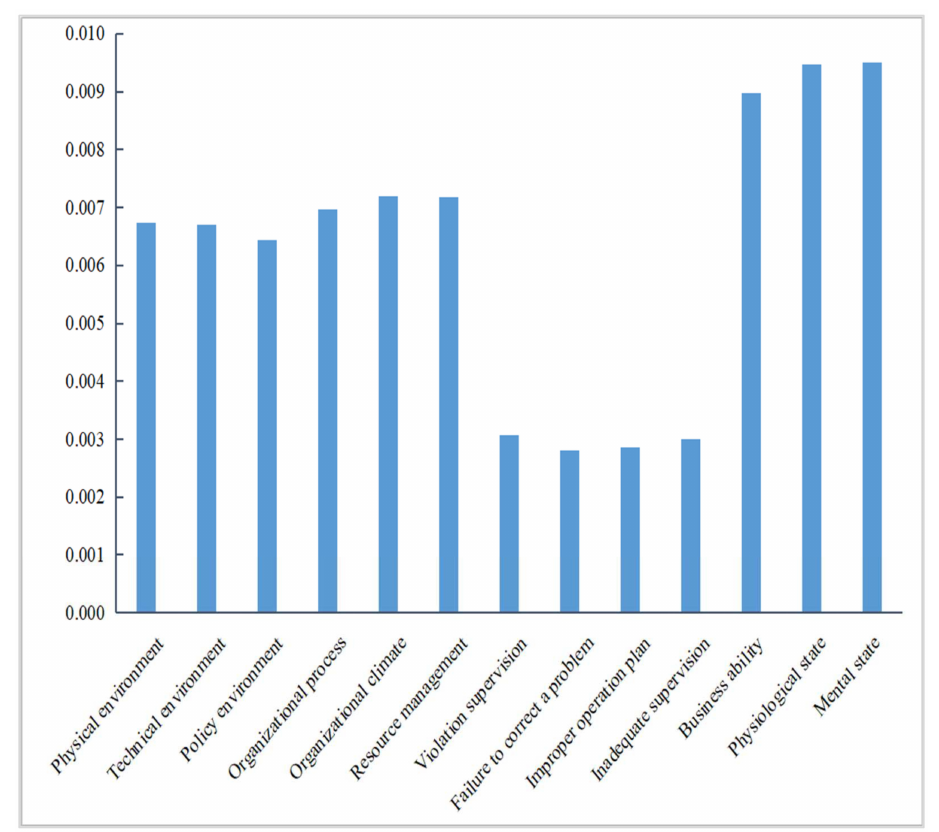
Figure 11. The CR value of the influence of risk factors on miners’ unsafe behavior.